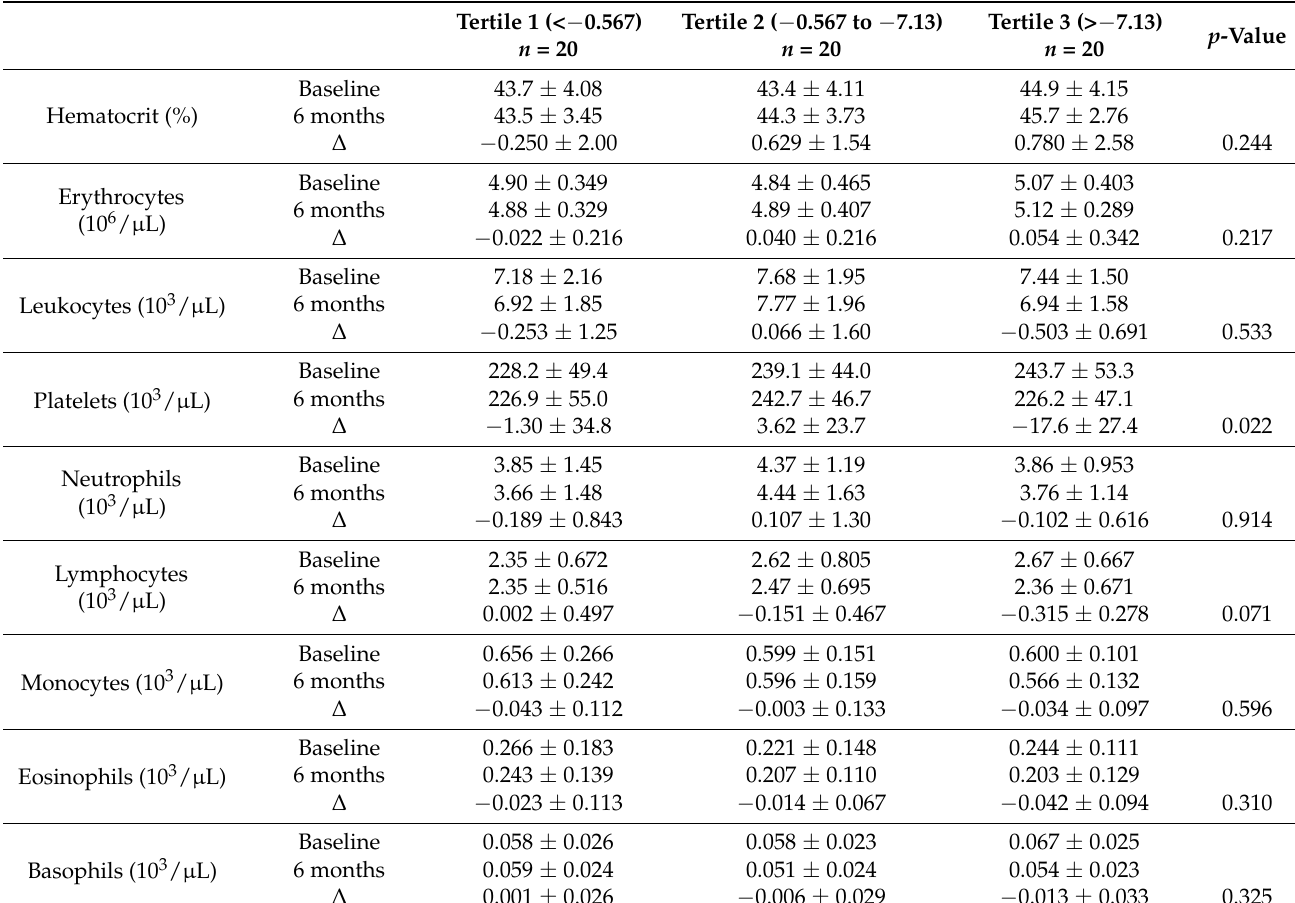
Table 2. Changes in hematological parameters of adults with nonalcoholic fatty liver disease (NAFLD) categorized by tertiles of 6 months change in intrahepatic fat content